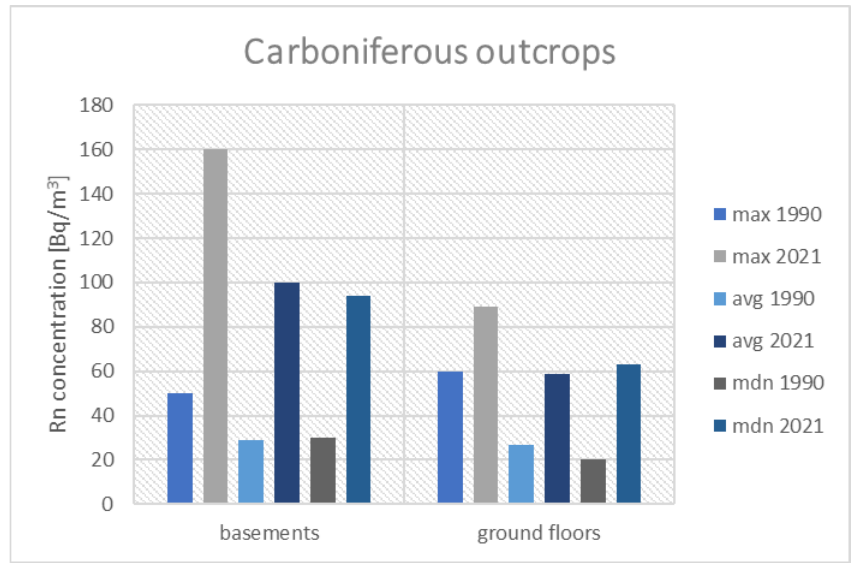
Figure 6. Comparison of radon concentrations in buildings located on Carboniferous outcrops.